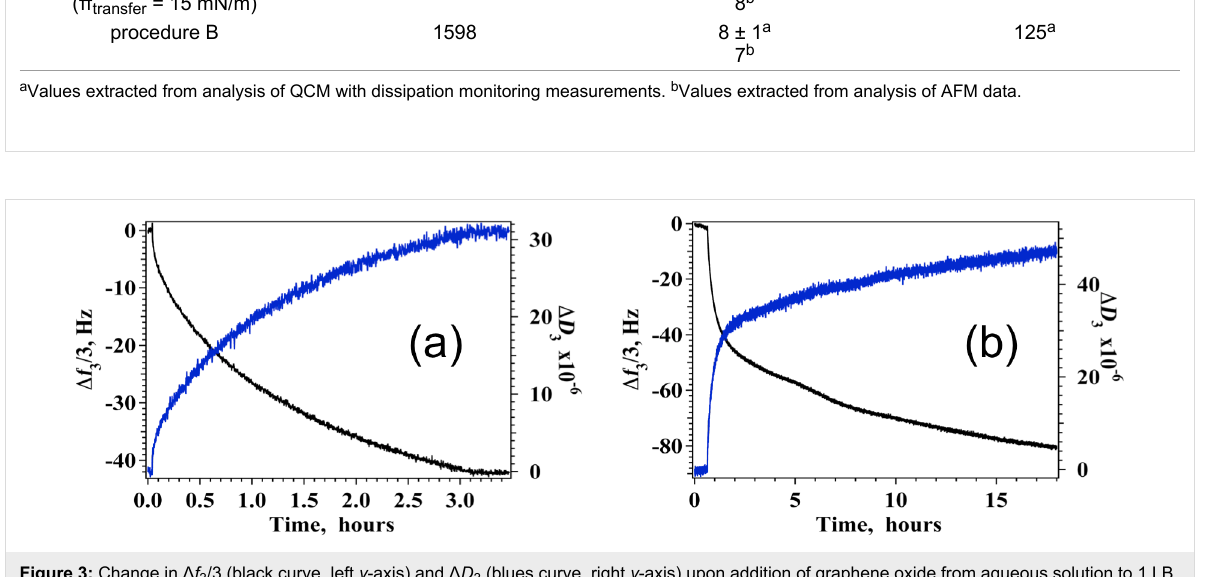
Figure 3: Change in Δ f 3 /3 (black curve, left y -axis) and Δ D 3 (blues curve, right y -axis) upon addition of graphene oxide from aqueous solution to 1 LB layer of silver nanocubes transferred at 15 mN/m (a) and to silver nanocubes arrays assembled by spontaneous adsorption (b). In all experiments [GO] = 40 mg L − 1 and T = 20